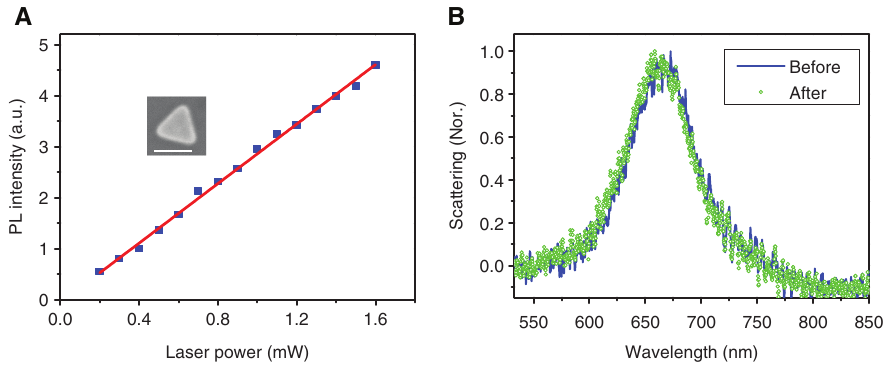
Figure 4: The property of one-photon PL from a single Ag TNP. (A) Relationship between the PL intensity integrated under the whole spectrum from a single Ag TNP (as shown in the inset SEM image) and the excitation power (532 nm, CW laser). When the excitation power is below 1.6 mW, the relationship is linear, revealing that the PL from the Ag TNP is due to one-photon excitation. (B) The scattering spectra for the tracked Ag TNP before and after the PL